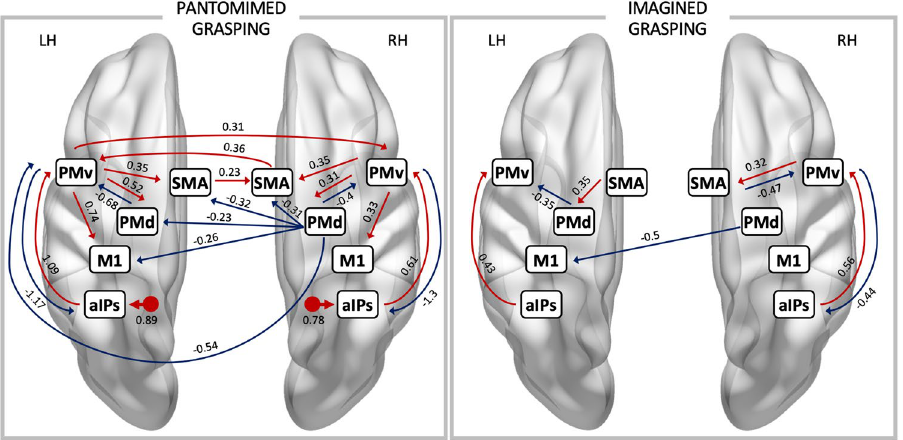
Figure 4. PEB results—(B) and (C) matrices. Schematic representation of the direct ( C matrix) and modulatory ( B matrix) effect on the effective connectivity within the network, separately for the pantomimed grasping (left panel) and the imagined grasping (right panel) condition. Only suprathreshold parameters (posterior probability > 0.95) are shown: red lines denote excitatory connections; blue lines stand for inhibitory connections. The direct effect ( C matrix) on aIPs, where exceeding the threshold, is displayed as a dot with a left/ right arrow. Connection strengths are also reported. Regions are denoted as aIPs (anterior intraparietal sulcus area), PMv (ventral premotor area), PMd (dorsal premotor area), SMA (supplementary motor area), and M1 (primary motor